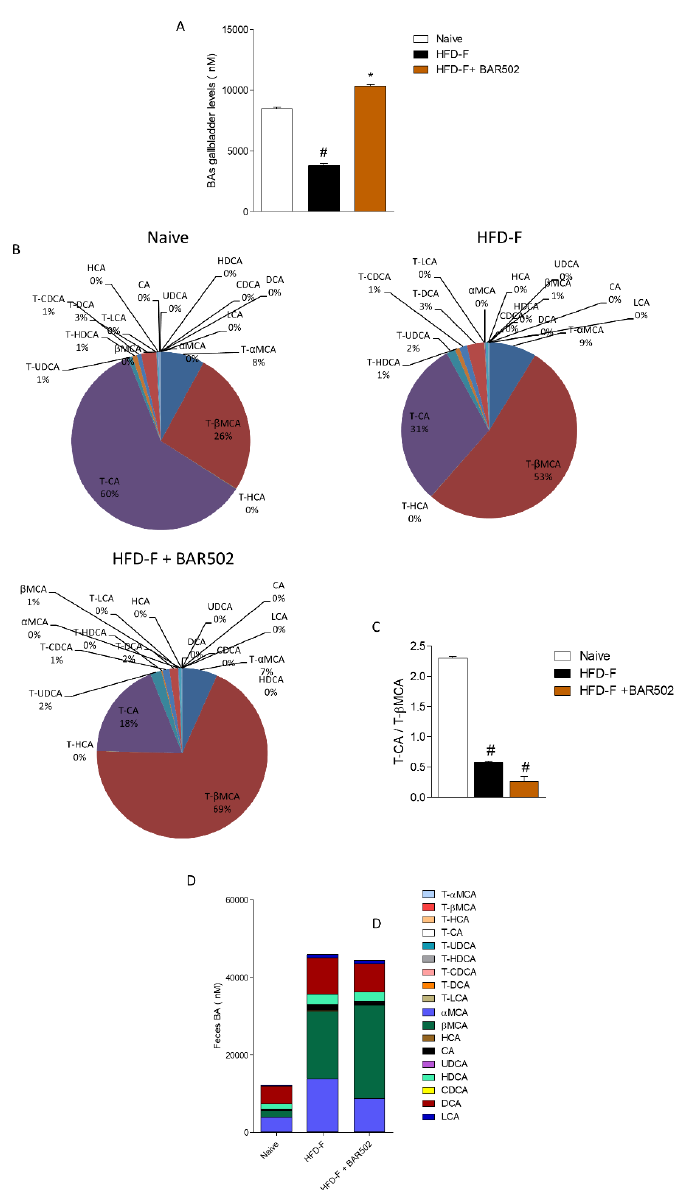
Figure 6. Analysis of gallbladder and fecal BAs composition. BAR502, 20 mg / kg / day, was administered by gavage in C57BL / 6J male mice starting on day 10 of HFD and fructose for an additional 11 weeks. ( A ) Total concentrations of gallbladder bile acids. ( B ) Composition % of gallbladder bile acids pool in NT, HFD–F, and HFD–F + BAR502 mice. ( C ) Ratio tauro- cholic acid (T-CA) / tauro-beta muricholic acid (T- β MCA 0in gallbladder samples. ( D ) Composition of fecal bile acids pool. Data are the mean ± SEM of 7–10 mice per group. In each panel # denotes p < 0.05 versus Naïve mice, * denotes p < 0.05 versus HFD–F